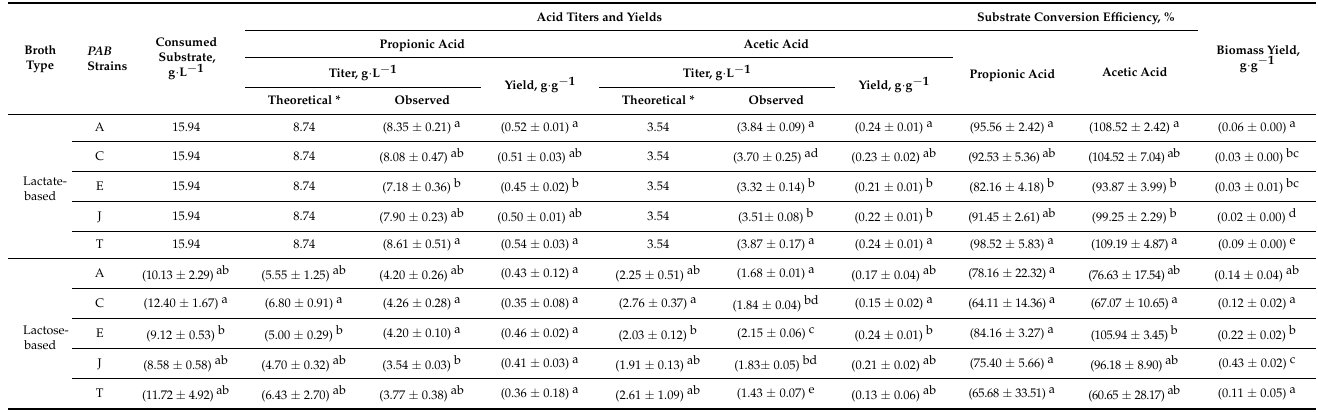
Table 3. Substrate consumption, conversion efficiency and outcomes of main acids and biomass by different PAB strains cultivated in lactose- or lactate-based